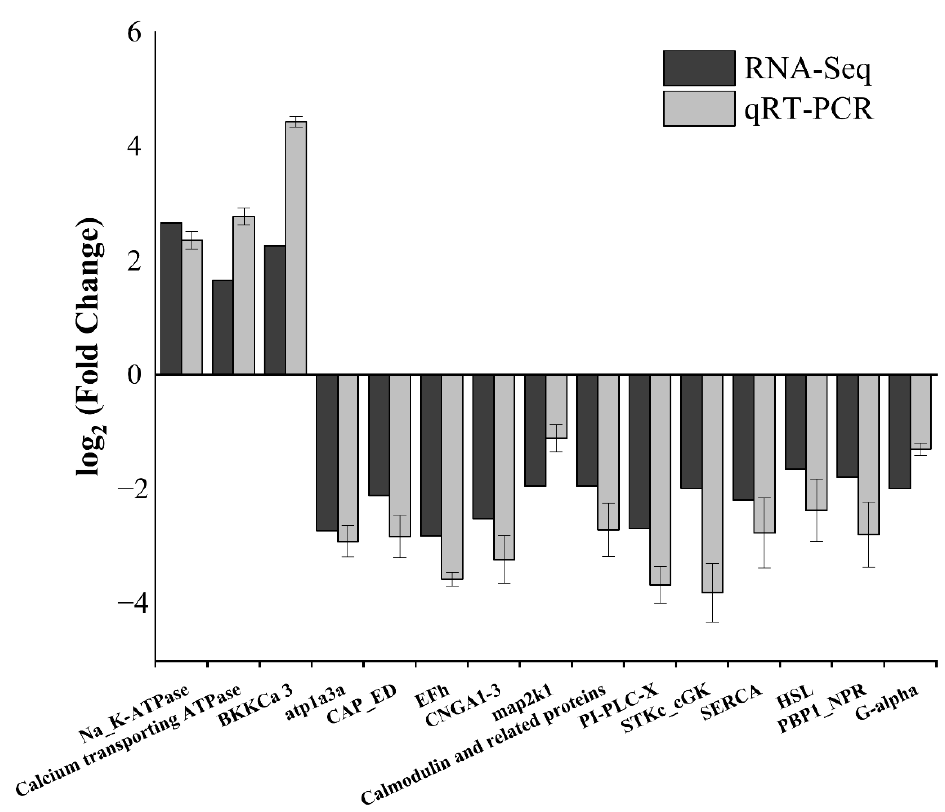
Figure 8. Comparison of the expressions of RNA-Seq and qRT-PCR results.